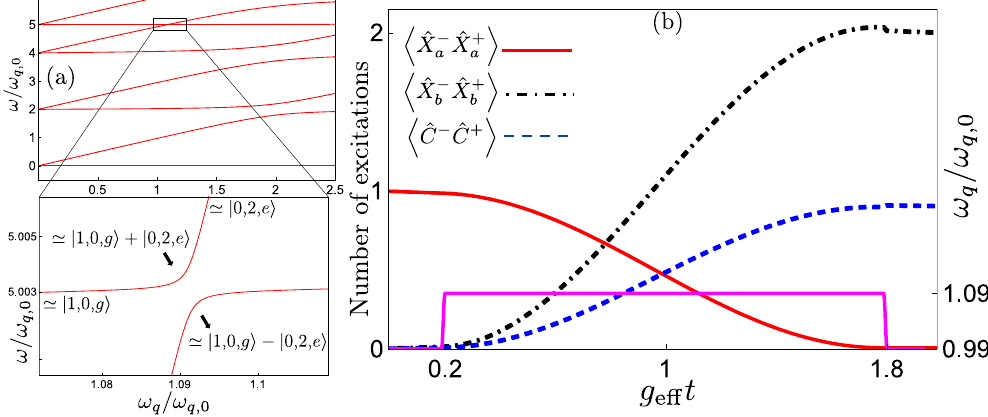
Figure 6. Two-photon frequency conversion via transitions between |1, 0, g 〉 and |0, 2, e 〉 . (a) The energy levels of our system, given in Eq. (6), plotted as a function of the qubit frequency ω q , using the parameters g a = g b = 0.2 ω q ,0 , ω a = 5 ω q ,0 , and ω b = 2 ω q ,0 , where the reference point ω q ,0 is set such that ω a = 2 ω b + ω q ,0 . In the zoom-in, close to the resonance ω a = 2 ω b + ω q , we see the anticrossing between |1, 0, g 〉 and |0, 2, e 〉 with the splitting 2 g levels in the figure from |0, 2, e 〉 to |1, 0, g 〉 , or vice versa. (b) A rapid frequency conversion can be achieved by starting in |1, 0, g 〉 or |0, 2, e 〉 , far from the resonance ω a = 2 ω b + ω q , tuning the qubit frequency (pink solid curve, a smoothed step function as explained in Fig. 3) into resonance for half a Rabi period ( π /2 g eff ) and then tuning it out of resonance again. The figure shows the number of excitations in the two resonators (red solid curve for a , black dashed-dotted curve for b ) and the qubit (blue dashed curve) during such a process, including decoherence in the form of relaxation from the resonators and the qubit. The parameters used for the decoherence are κ a = κ b = γ = 2 × 10 − 5 ω q ,0 .